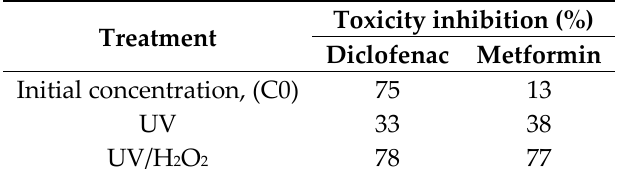
Table 3. Results of toxicity inhibition tests of DIC and MET after UV